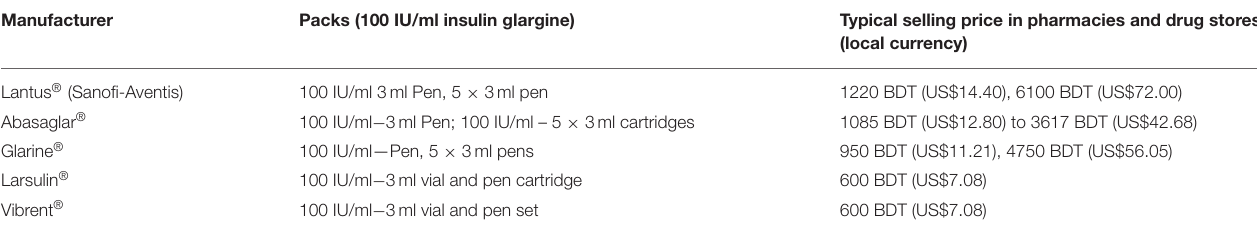
TABLE 5 | Typical selling prices for a range of insulin glargine preparations among 58 pharmacies and drug stores in Bangladesh. Manufacturer